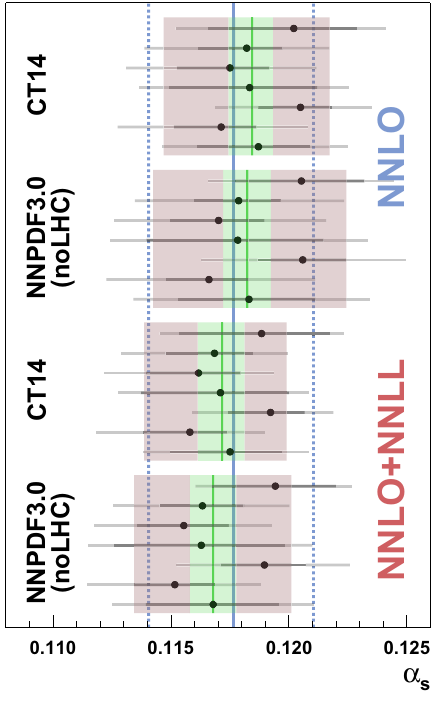
Fig. 4 Combination results for all PDF sets taken into consideration, at NNLO and NNLO + NNLL. The solid blue line is the unweighted average of the individual combination results, and the dashed blue lines represent the 68% confidence interval. The red and green bands are as in Fig.